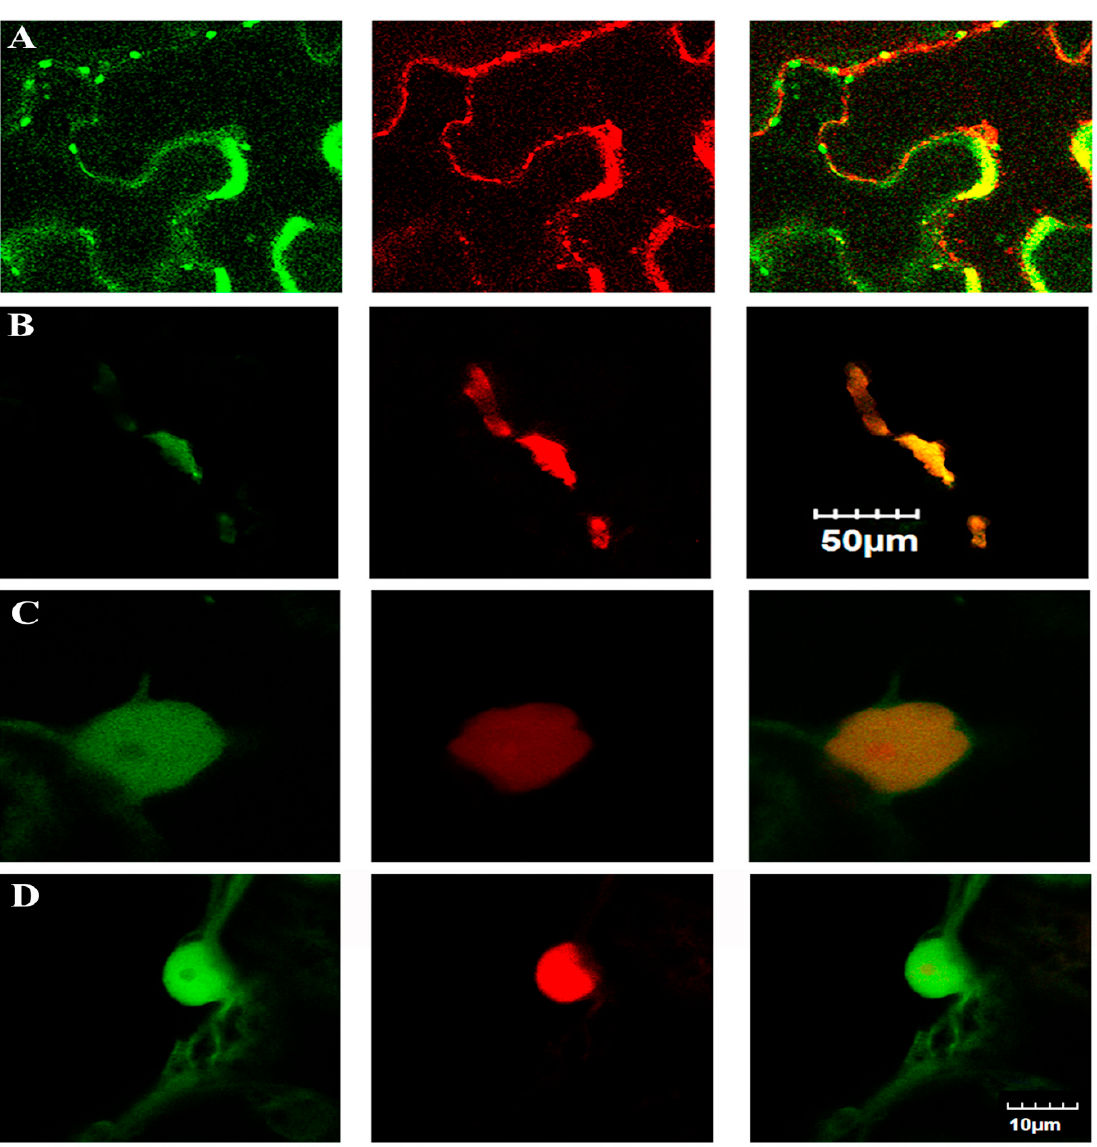
Figure 4. Subcellular localization of CLIBASIA_05150, CLIBASIA_04065, CLIBASIA_00470, and CLIBASIA_04025. ( A ) Showed the subcellular location of CLIBASIA_05150. The left one showed CLIBASIA_05150-GFP fusion protein, middle showed RFP targeted to Golgi apparatus, the right one showed overlay of left and middle. ( B ) Showed the subcellular localization of CLIBASIA_04065. Left showed the CLIBASIA_04065-GFP fusion protein, middle was RFP targeted to mitochondria, right showed overlay of left and middle. ( C , D ) Showed the subcellular localization of CLIBASIA_00470 and CLIBASIA_04025, respectively. Left showed GFP fusion protein, middle showed RFP with nuclear localization signal (NLS), right showed overlay of left and middle. A and B were the same scale; C and D were the same